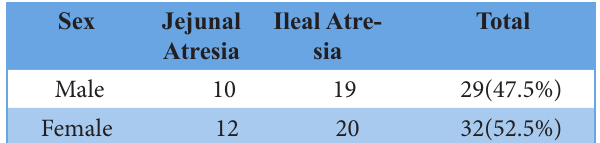
Table 1. Sex wise distribution of patients